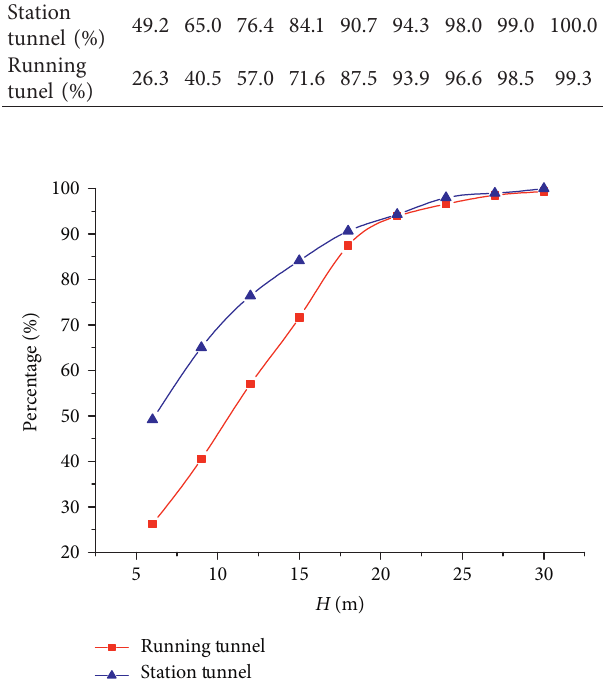
Figure 13: GSEA proportion variation for metro tunnel under different buried